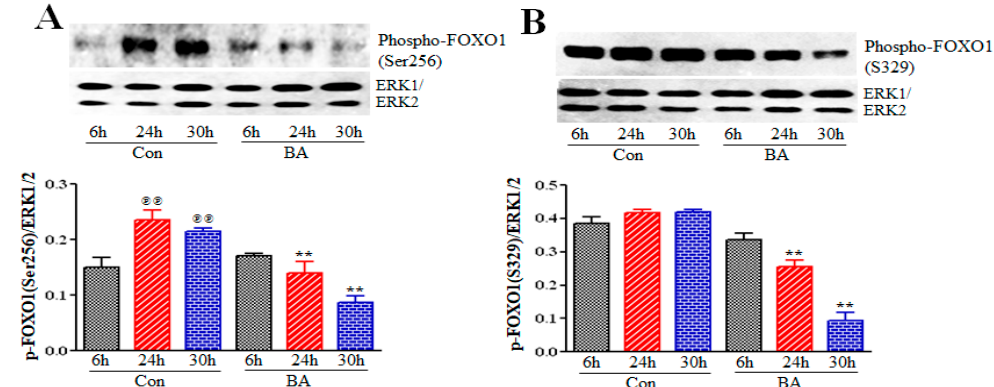
Figure 5. Evaluation of butyrate influence on phosphorylation state of FOXO1. VSMCs treated with (BA) or without (Con) butyrate for indicated periods were processed for Western blot analysis of phosphorylated FOXO1 at Ser256 and Ser329. ( A ) Phosphorylation state of FOXO1 at Ser256 is assessed by immunoblotting with antibody specific for FOXO1 phosphorylated at Ser256. ( ℗℗ p < 0.001 vs 6 h control) and is notably reduced in butyrate-treated VSMCs at 24 h and 30 h (** p < 0.001 vs respective control). ( B ) Phosphorylation of FOXO1 at Ser329 is determined by the antibody specific to FOXO1 phosphorylated at Ser329. (** p < 0.001 vs respective control).